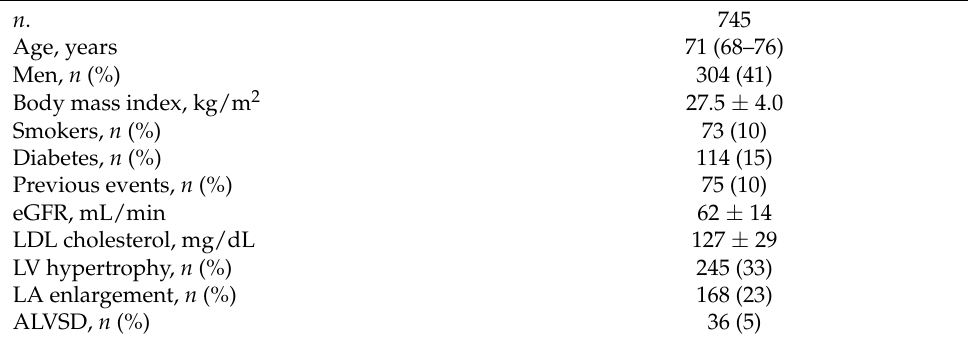
Table 1. Characteristics of the study population.